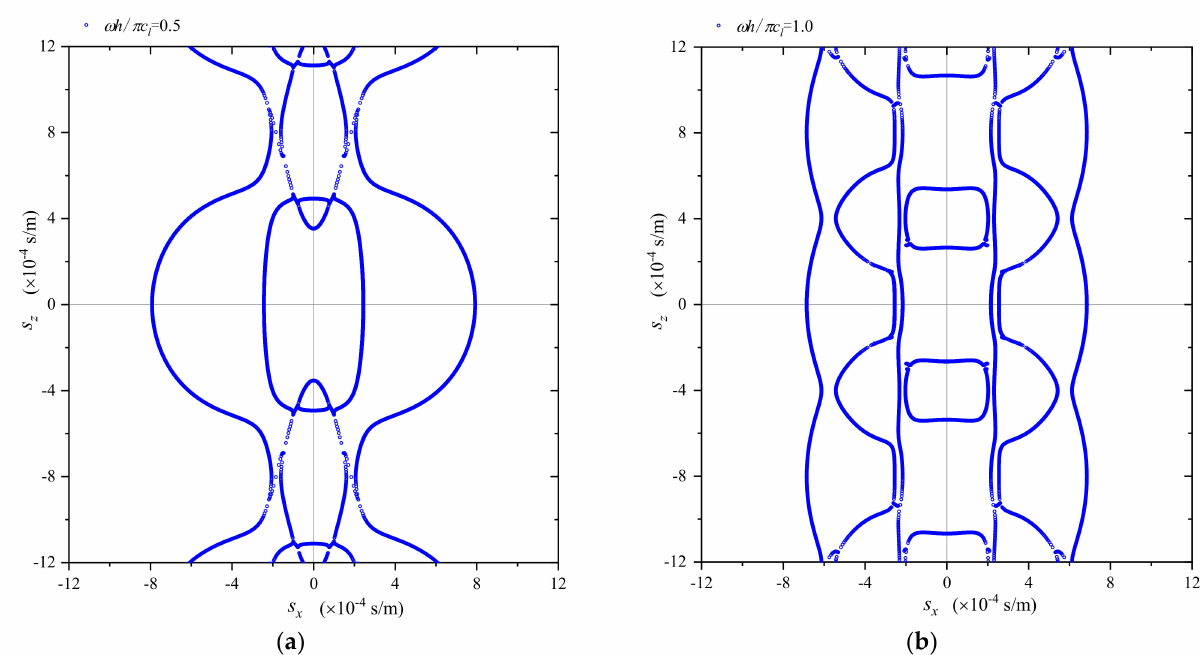
Figure 10. The slowness curves of the Floquet in–plane waves propagating in the XOZ plane of the exemplified periodically octal–layered isotropic media with dimensionless frequency ( a ) ω = 0.5 and ( b ) ω =